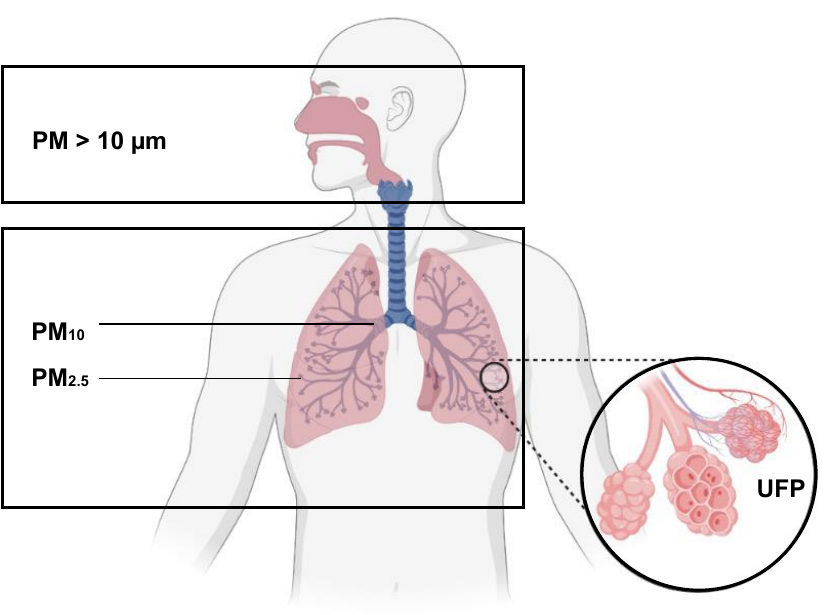
Figure 1. Deposition of particulate matter in the airways. Particulate matter (PM) consists of several particle sizes which deposit in the airways at different levels. PM > 10 µm will accumulate in the upper airways and filtered by the nose. PM < 10 µm (PM 10 ) will penetrate in the lower airways up to the level of the conducting airways. PM < 2.5 µm (PM 2.5 ) will also deposit in the lower airways but will accumulate deeper in the terminal bronchioles and alveoli. Ultrafine particles (UFP < 0.1 µm) will reside at the level of the alveoli in the lower airways and can even diffuse into the systemic circulation. Created with BioRender.com.